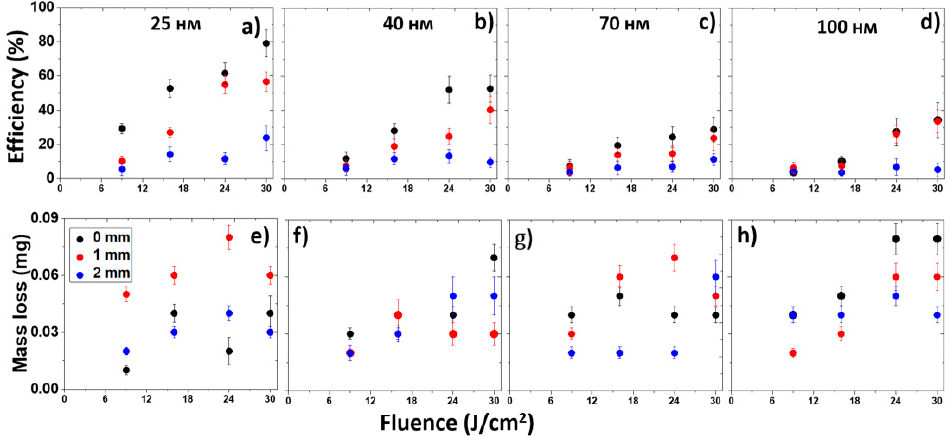
Figure 3. Dependence of the laser transfer efficiency evaluated from the optical density at 380 nm ( a – d ) and mass loss ( e – h ) for different distances between the target and the glass substrate on the laser